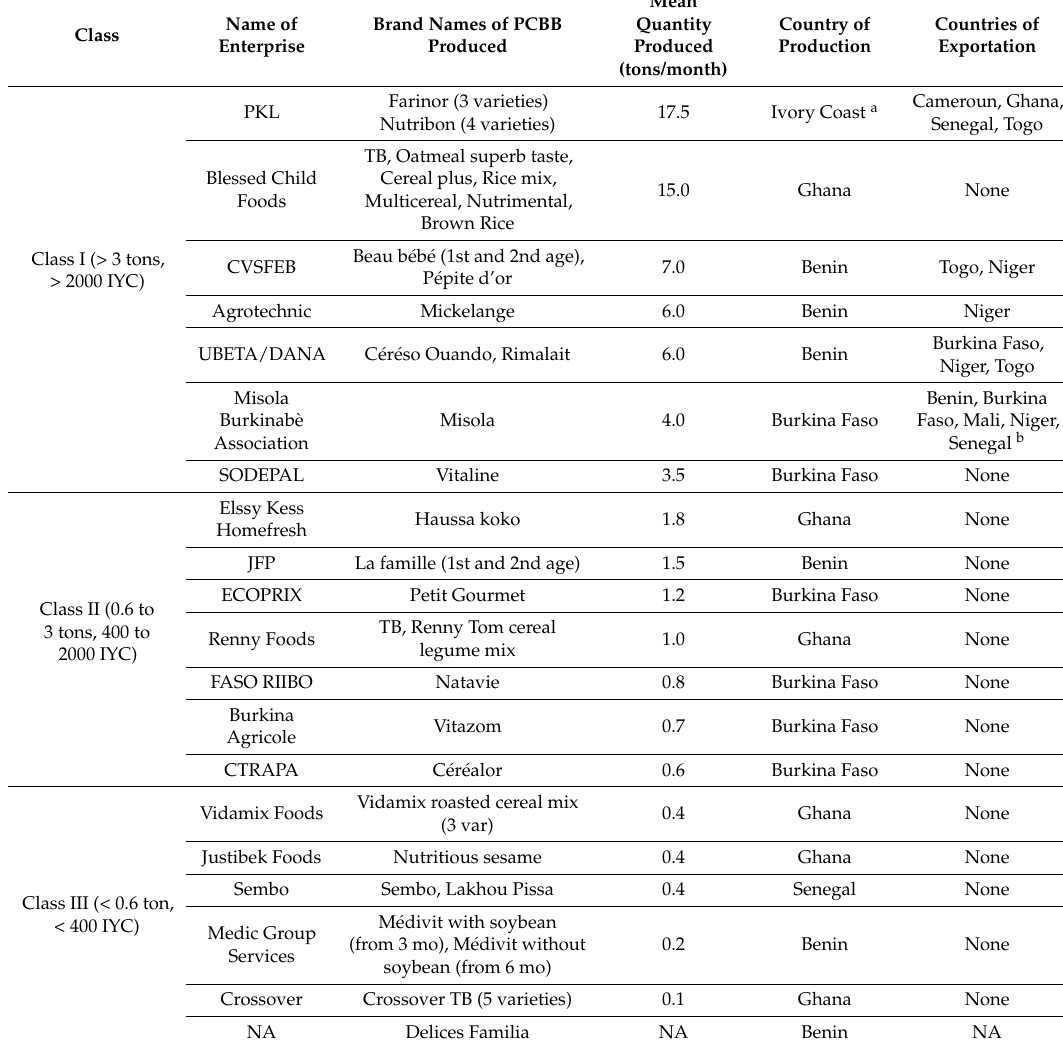
Table 2. Classification of producers surveyed according to the estimated quantity of PCBBs